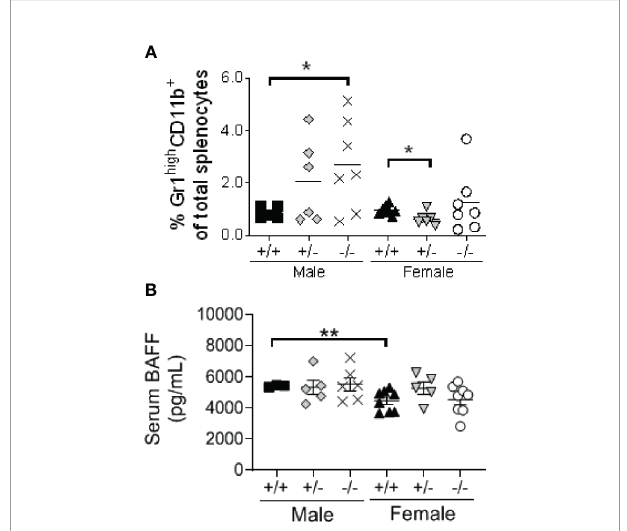
( Figure 8F ). Further analysis of LDGs in NZBWF1 mice identi fi ed elevated Ifna transcripts in both Ly6C high (Gr1 low ) and Ly6C low (Gr1 high ) LDG subsets, although differences only reached statistical signi fi cance in the Ly6C high CD11b + SSC low population ( Supplemental Figure 4 ).